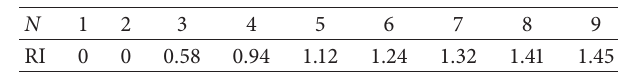
Table 2: Values of